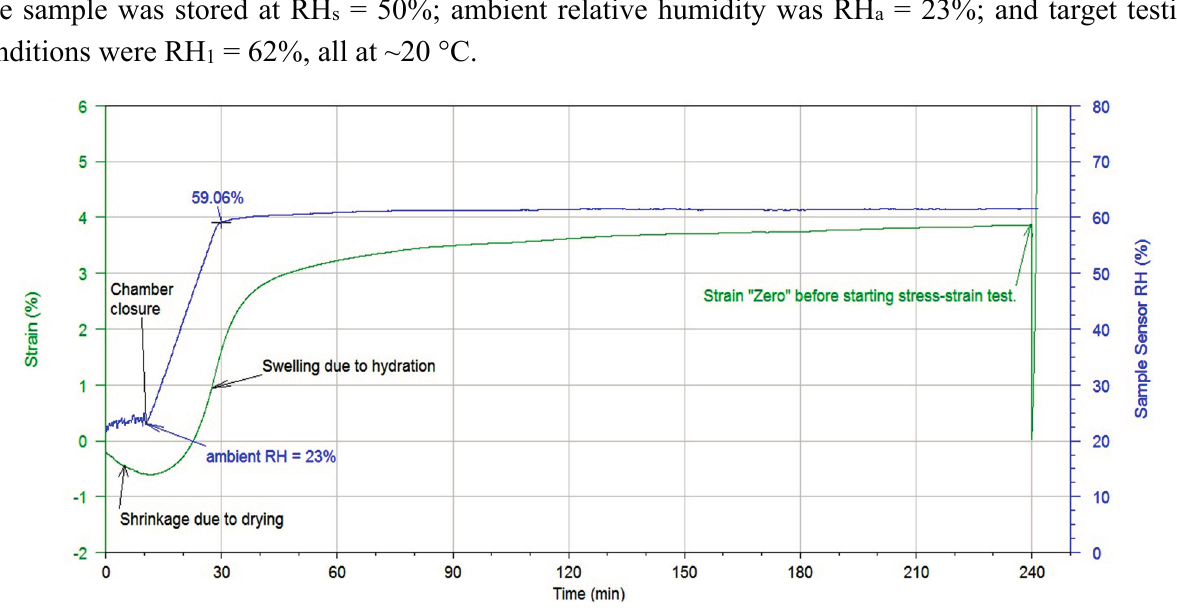
Figure 4. Pre-conditioning of a ~0.05 mm CaCas/Gly film sample inside the DMA-RH chamber: storage at RH s = 50%; ambient RH a = 23%; target RH 1 = 60%. Legend: Blue = RH, Green = Strain% (sample